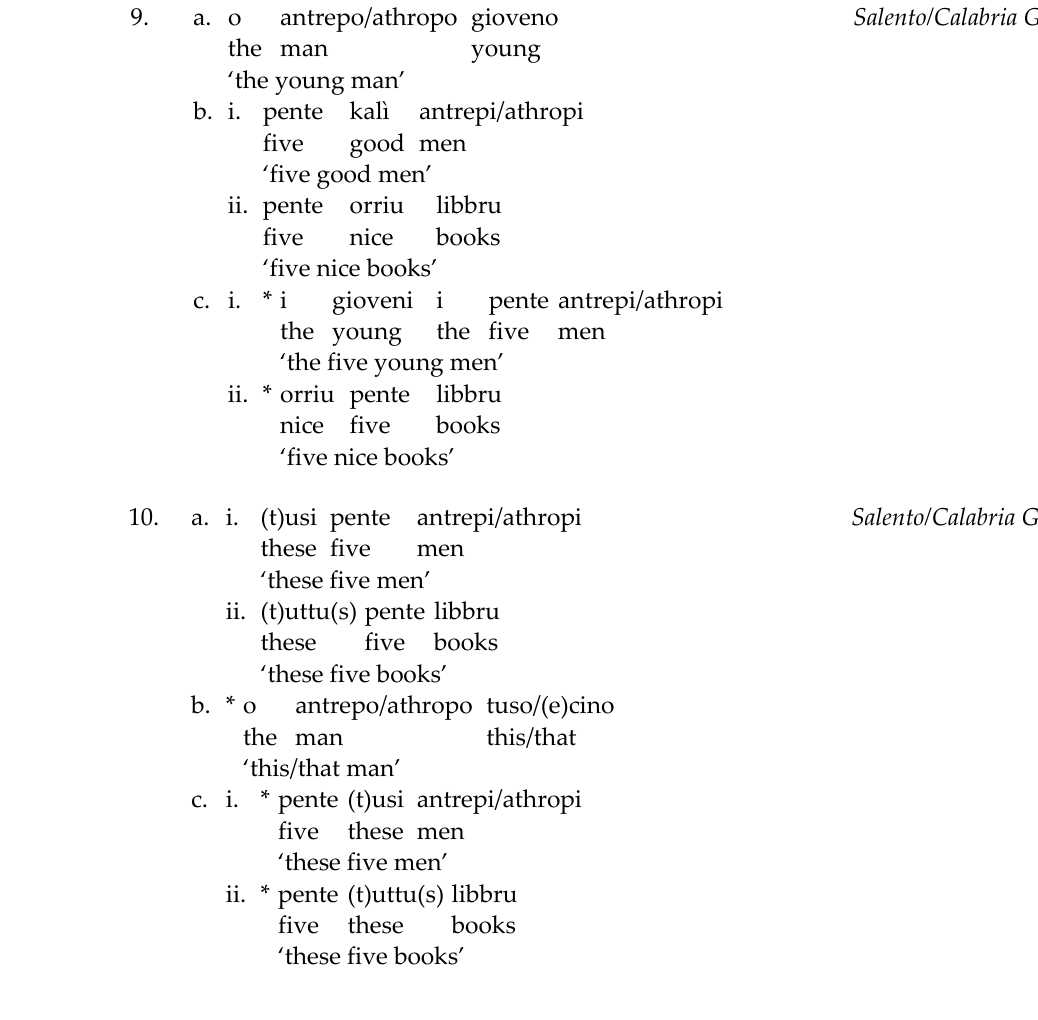
Table 1. Num N X .